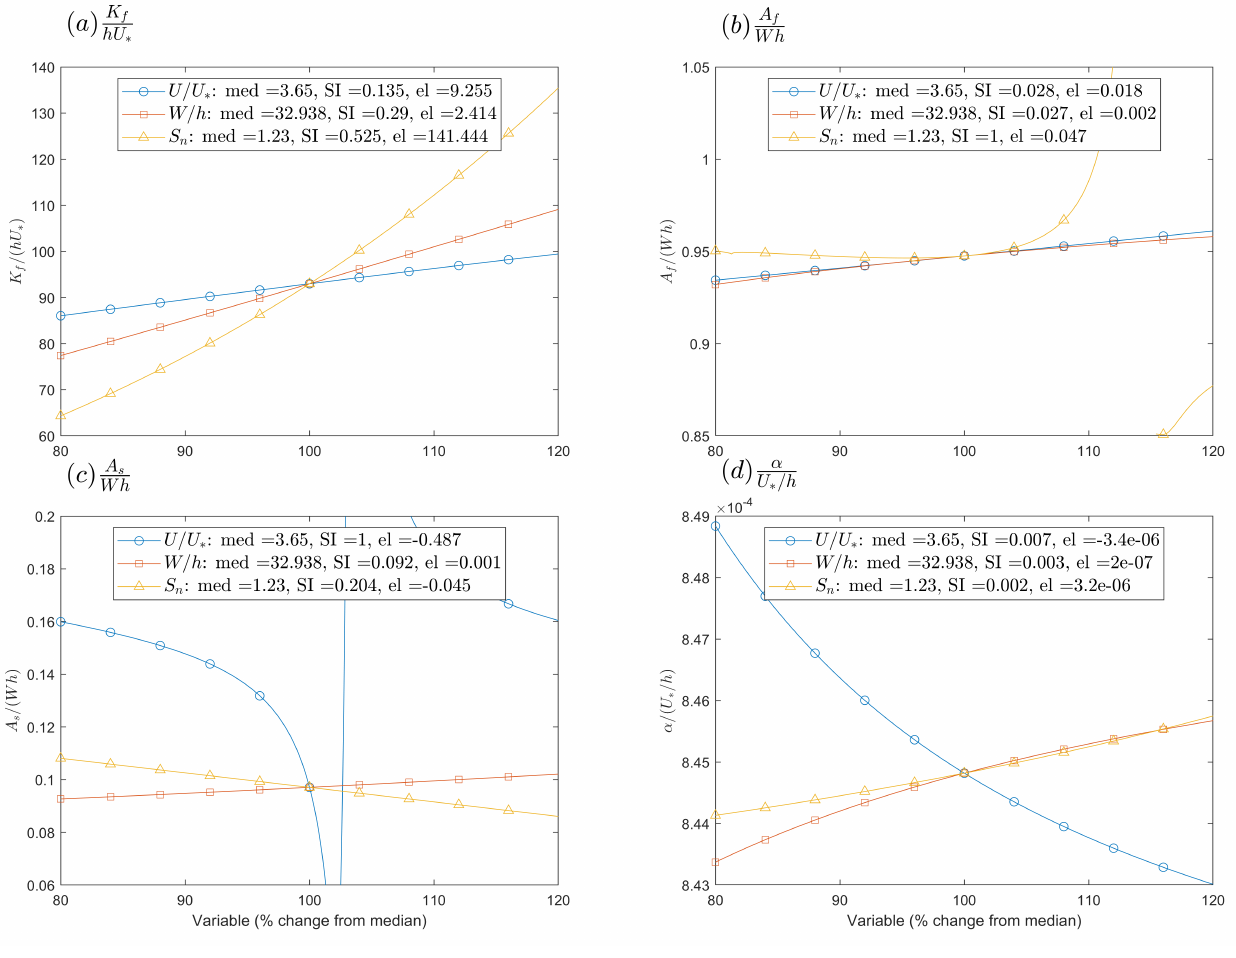
A f . ( b ) . ( c ) A s . ( d ) α hU ∗ Wh Wh U ∗ / h